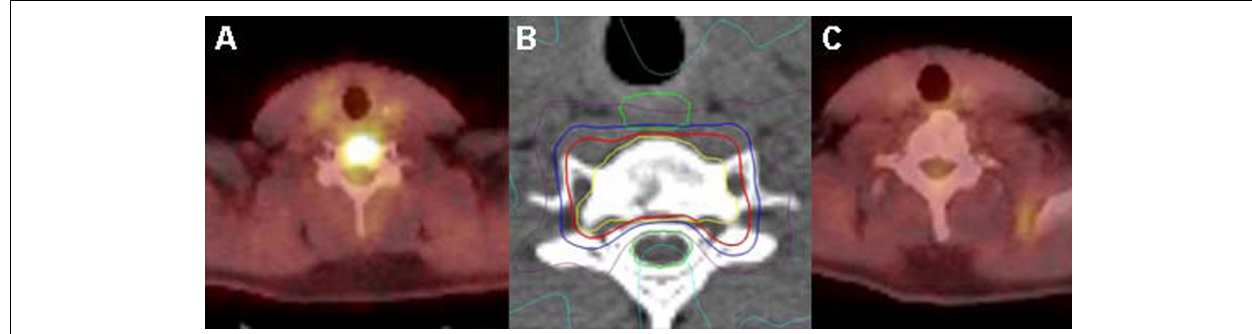
FIGURE 1 | Osteosarcoma C6 oligometastasis PET/CT scan with a tumor SUV max of 11 (A) ; (B) CyberKnife treatment plan showing the vertebral body planning treatment volume in yellow and the 35 Gy isodose line in blue; and (C) PET/CT scan at 3 years post-treatment shows a durable complete response with a tumor SUV max of